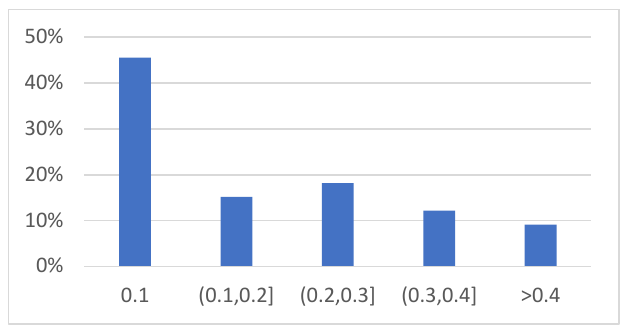
Figure 3. Distribution of the size of aloe vera crops in the sample (source: own elaboration).